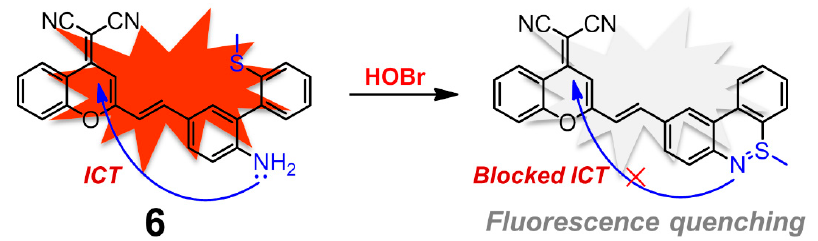
Figure 7. Dicyanomethylene-benzopyran (DCMB)-based near-infrared (NIR) fluorescent probe 6 for HOBr in a fluorescence quenching manner.